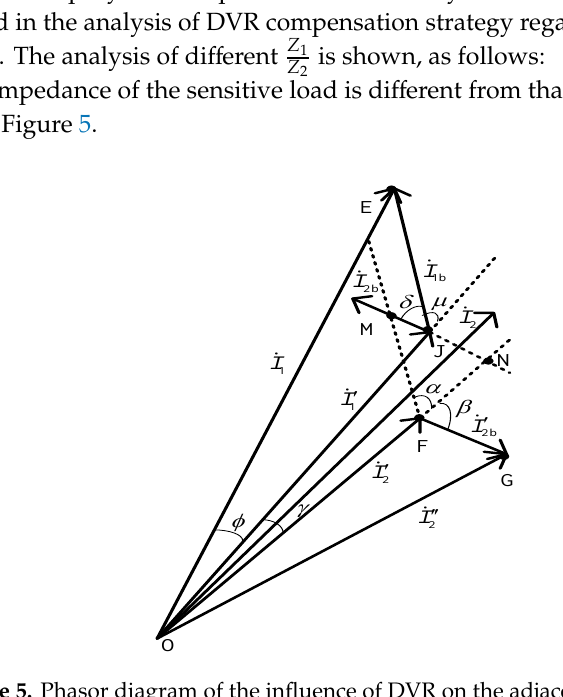
(cid:48) (cid:48) . . ( ) in the Figure 6 means that I I 1 2